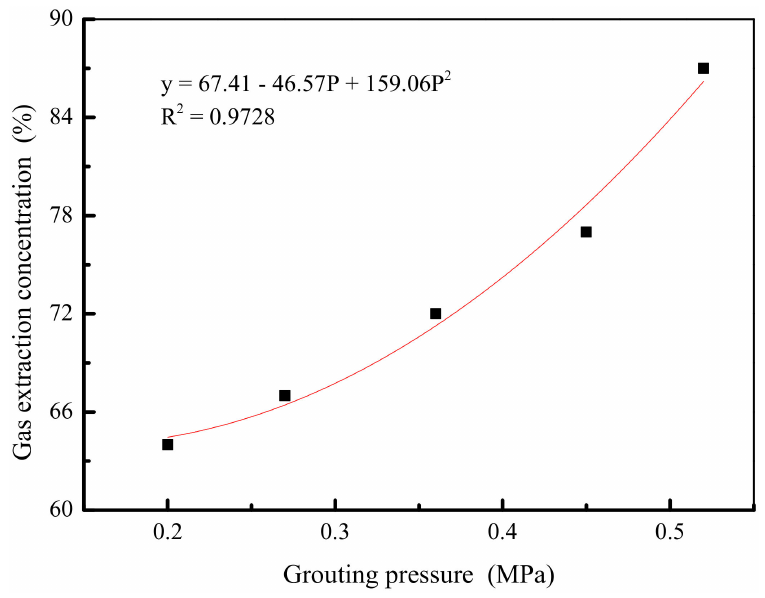
Figure 11. Relationship between sealing pressure and average concentration of gas